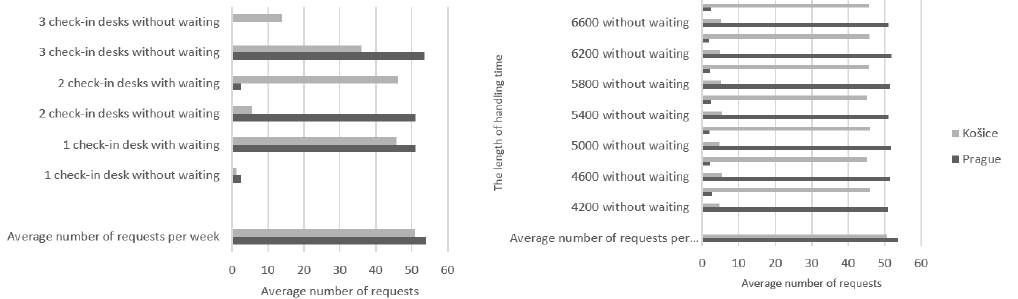
Figure 11. The effect of changing the number of check-in desks and the length of handling time on the number of requests handled without waiting/with waiting.